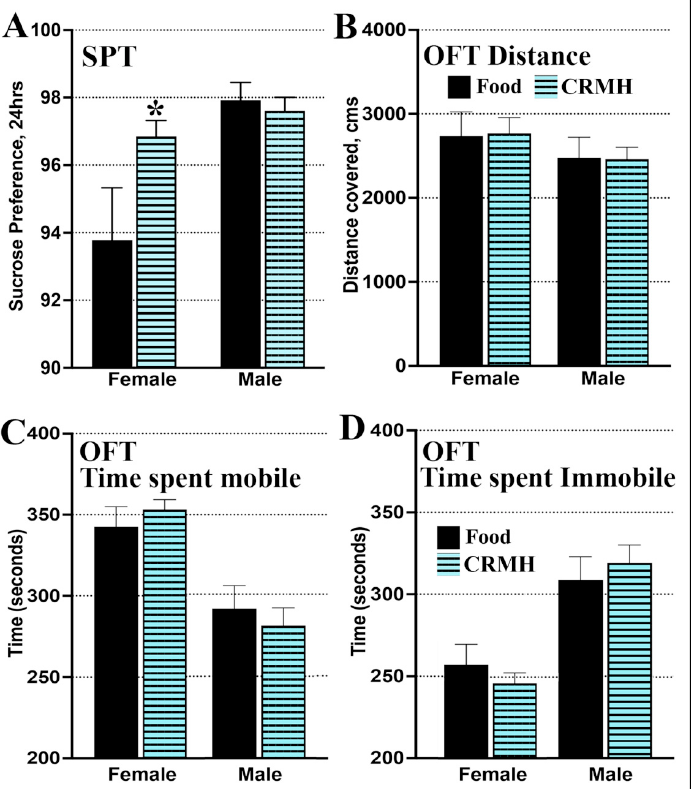
Figure 6. Dietary CRMH reduces anhedonia in the sucrose preference in only females at altitude and does not alter motor behavior in the open field test in either sex. ( A ). Females at altitude showed an increase in sucrose preference after dietary CRMH treatment vs. food, while males at altitude showed no difference between food and CRMH groups in the SPT. For OFT behavior, both females and males at altitude did not vary in ( B ). total distance covered in the OFT, ( C ). time spent mobile in the OFT or ( D ). time spent immobile in the OFT. (Student’s t -test, * = p < 0.05 vs. food controls).